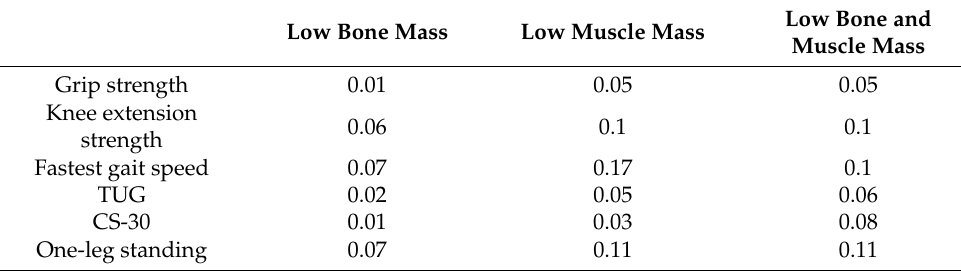
Table 4. Effect sizes of the differences between the healthy group and the other